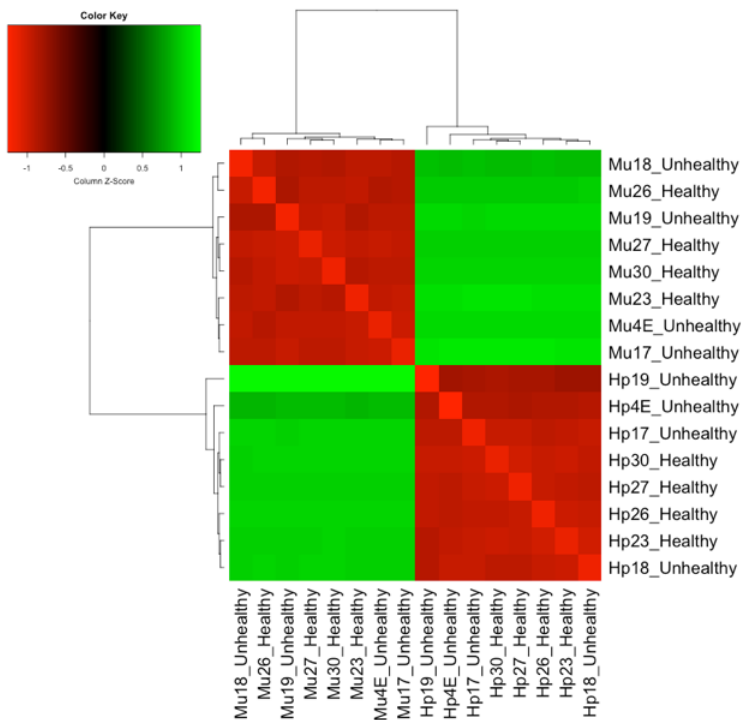
Figure 6. Distance between eight healthy and eight unhealthy paired samples considering the tissue e ff ect, based on the counts per million baseMean data. Note the hepatopancreas (Hp) and muscle (Mu) of Litopenaeus vannamei samples separated into di ff erent groups with greater Euclidian distances. Regarding the unhealthy and healthy conditions after WSSV (White Spot Syndrome Virus) exposure, the samples from healthy shrimps are grouped only for the hepatopancreas. The bright green color indicates the highest dissimilar gene expression profiles, evidencing samples with greater Euclidean distance between them. Hepatopancreas shows greater heterogeneity between the expression profiles of healthy and unhealthy animals when compared to muscle. Samples 23, 26, 27, and 30 are from healthy animals and 4, 17, 18, and 19 from unhealthy. Table 1. Summary of the Gene Ontology (GO), showing Biological Process (BP), Molecular Function (MF), and Cell Component (CC) terms (FDR < 0.1) from di ff erentially expressed genes between healthy and unhealthy Litopenaeus vannamei exposed to WSSV (White Spot Syndrome Virus), and resulting enriched